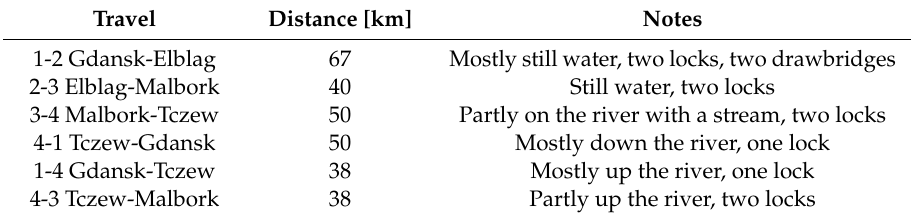
Figure 11. Sample journeys for the case study vessel. Table 2. Sample journeys for the case study vessel divided into